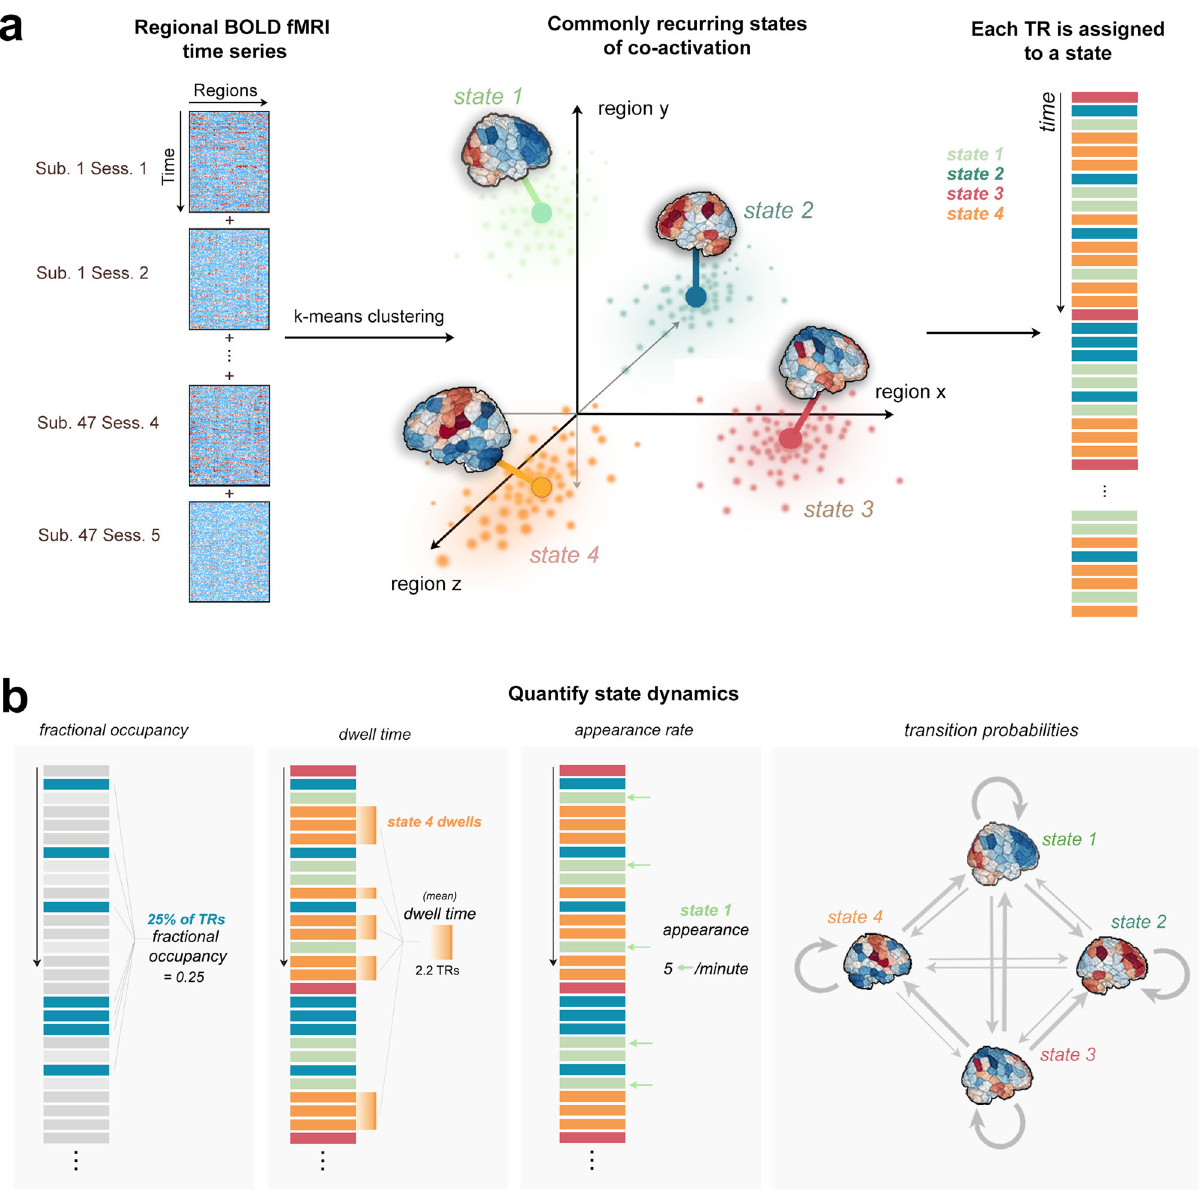
Fig. 1 Clustering of time series data and quanti fi cation of dynamic state metrics. a Time series data from all subjects were concatenated together along the time dimension. K-means clustering produced 4 distinct brain activation states de fi ned by different locations in regional activation space (image adapted from ref. 6 ). Each TR is assigned to one of four brain states based on k-means partitions. b Fractional occupancy, dwell time, appearance rate, and transition probabilities are calculated separately for each subject and for each